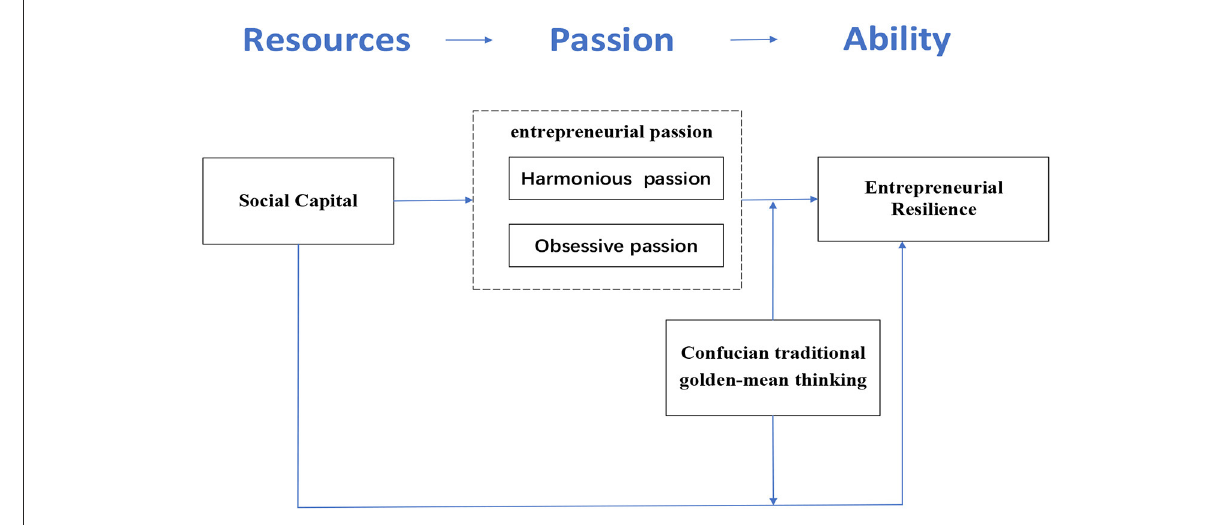
FIGURE1 The research